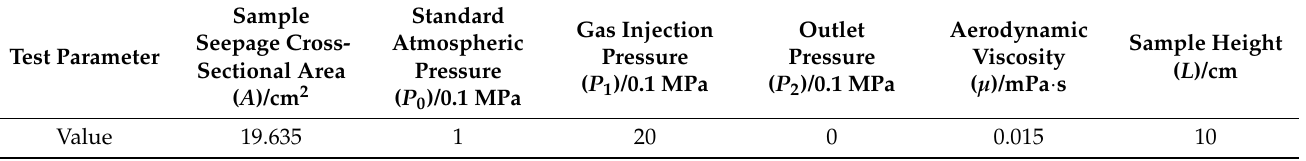
Table 1. Parameters in the permeability